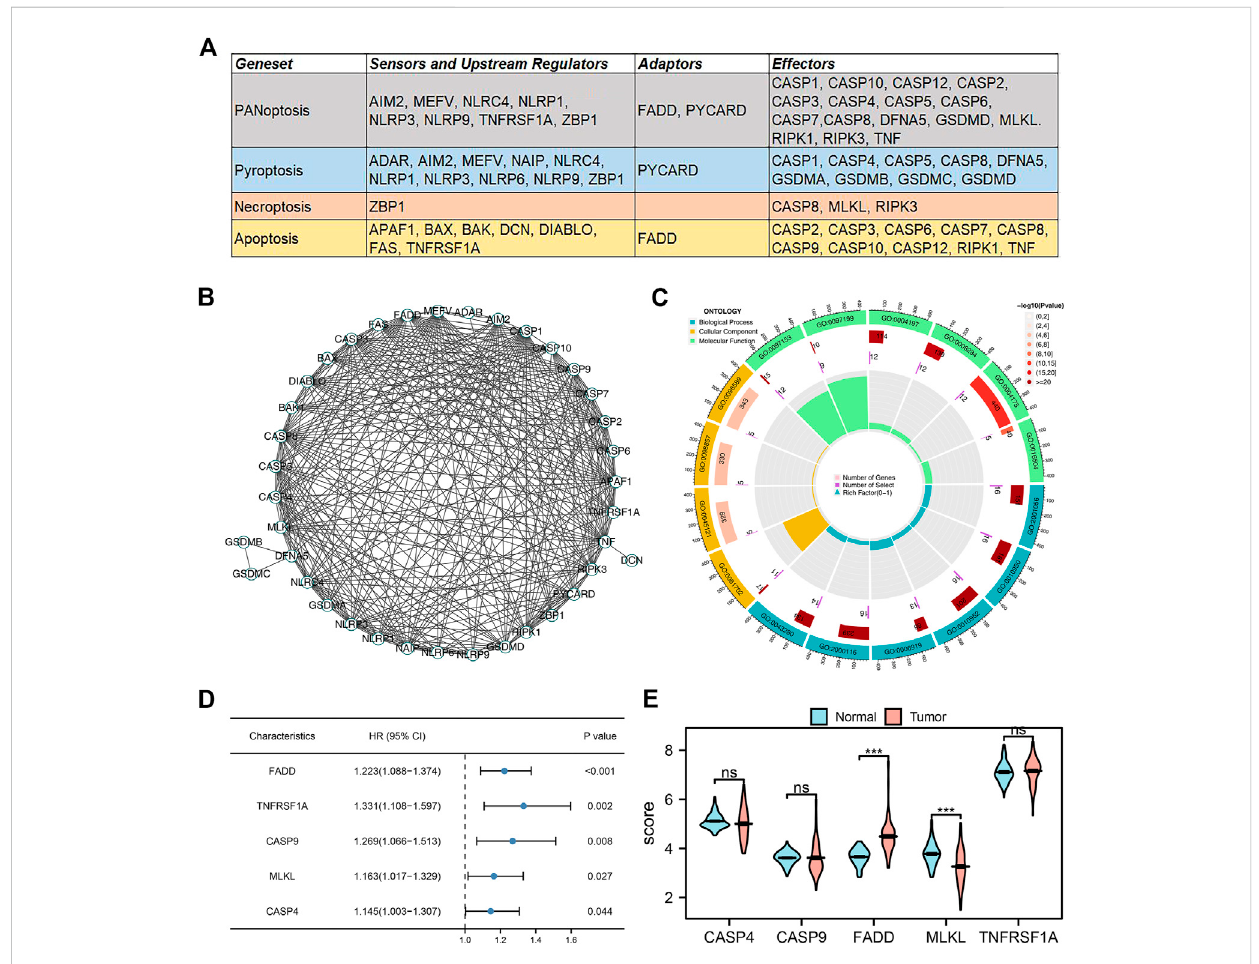
FIGURE 1 Identi fi cationofPANoptosis-relatedgenesinlungcancer.Notes: (A) ThePANoptosis-relatedgenescollectedfrompreviousstudies; (B) PPInetwork ofthesePANoptosis-relatedgenes; (C) GOanalysisofthesePANoptosis-relatedgenes; (D) UnivariateCoxregressionofthesePANoptosis-relatedgenes; (E) The expression level of CASP4, CASP9, FADD, MLKL and TNFRSF1A in tumor and normal